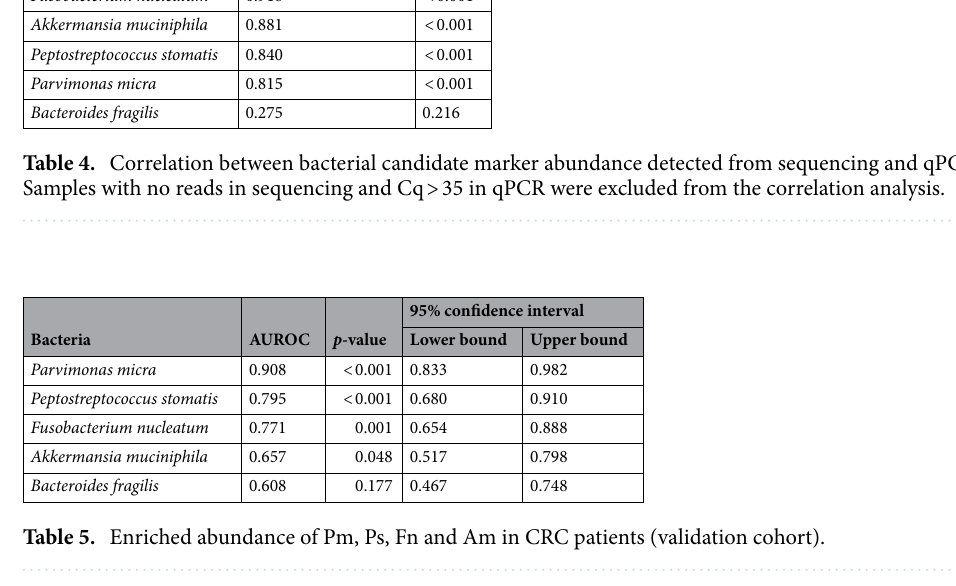
hand, non-CRC gut microbiome metabolic functions involved pathways such as transcription factors, pentose and glucuronate interconversions, lysine biosynthesis and glyoxylate and dicarboxylate metabolism (Fig. 5).